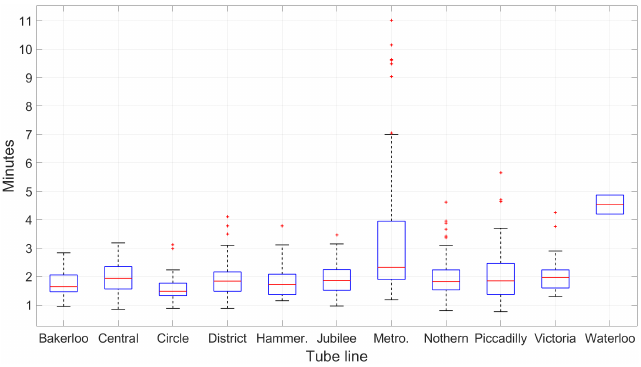
Figure 10. Overview of the travelling time between consecutive stations on all 11 lines: The majority of one-stop journeys fall between 1 min and 3 min. For each box, the red central line indicates the median; the bottom and top edges indicate the 25th and 75th percentiles. The whiskers extend to the furthest non-outlier data points, while the outliers are plotted individually as